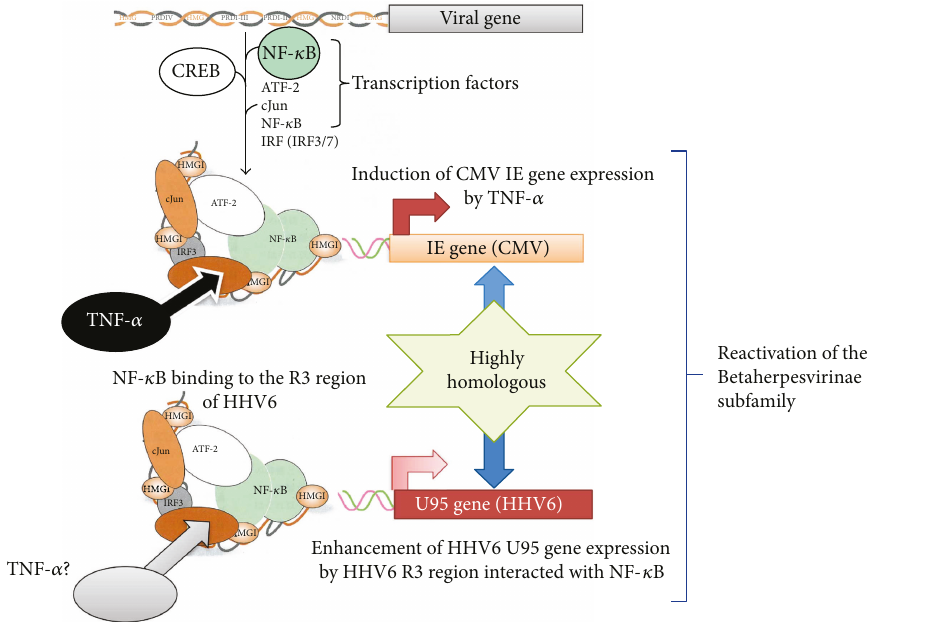
Figure 2: Possible involvement of tumor necrosis factor- (TNF-) α in the reactivation of cytomegalovirus (CMV) and human herpesvirus (HHV)-6. TNF- α may play a role in reactivation of Betaherpesvirinae subfamily members, including CMV and HHV-6. TNF- α enhances the expression of CMV immediate early gene products. Enhancement of HHV-6 U95 gene expression by the R3 region of HHV-6 might interact with nuclear factor- (NF-) κ B by TNF- α